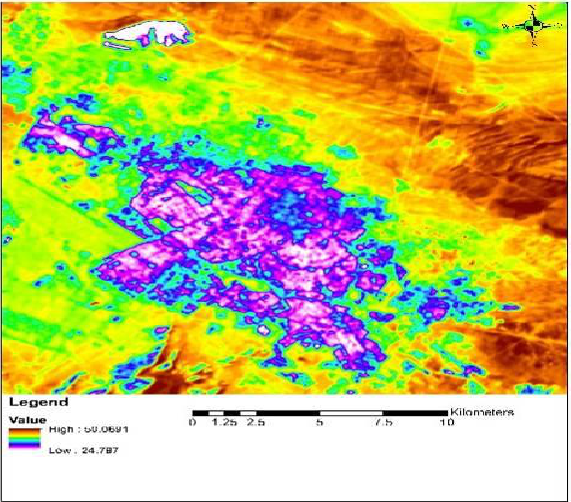
Figure 6. Thermal image of Yazd city clay- made houses have less temperature than surrounding areas (purple Figure 5. (a) Local sigma filter, (b) Enhanced lee filter, (c) Kuan filter.